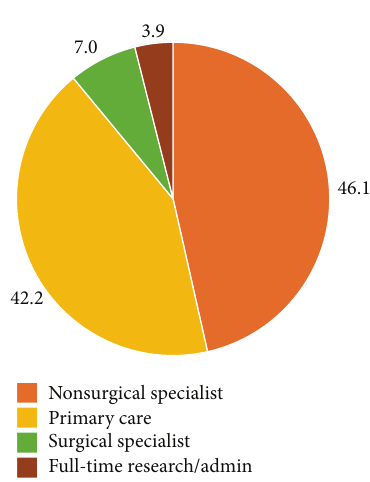
Figure 1: Canadian physicians divided by range of years they have been practicing. Data values represent frequencies in percentages ( 𝑁 = 128 ).